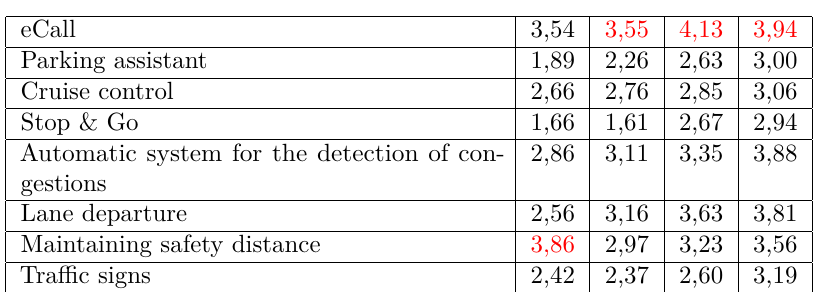
Table 4. Evaluation of the importance of active safety systems’ application in